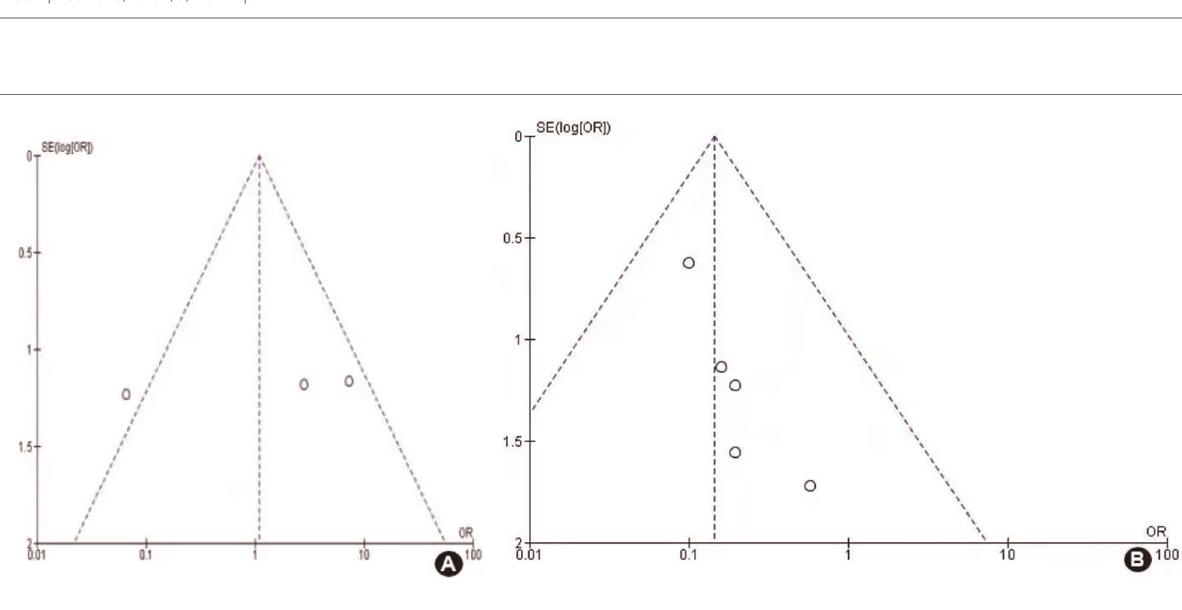
FIGURE 4 Forest plot of comparison complications of internal vs. external hemipelvectomy in pelvic tumors: ( A ) Wound complication, ( B ) genitourinary complications, and ( C ) fl ail hip.